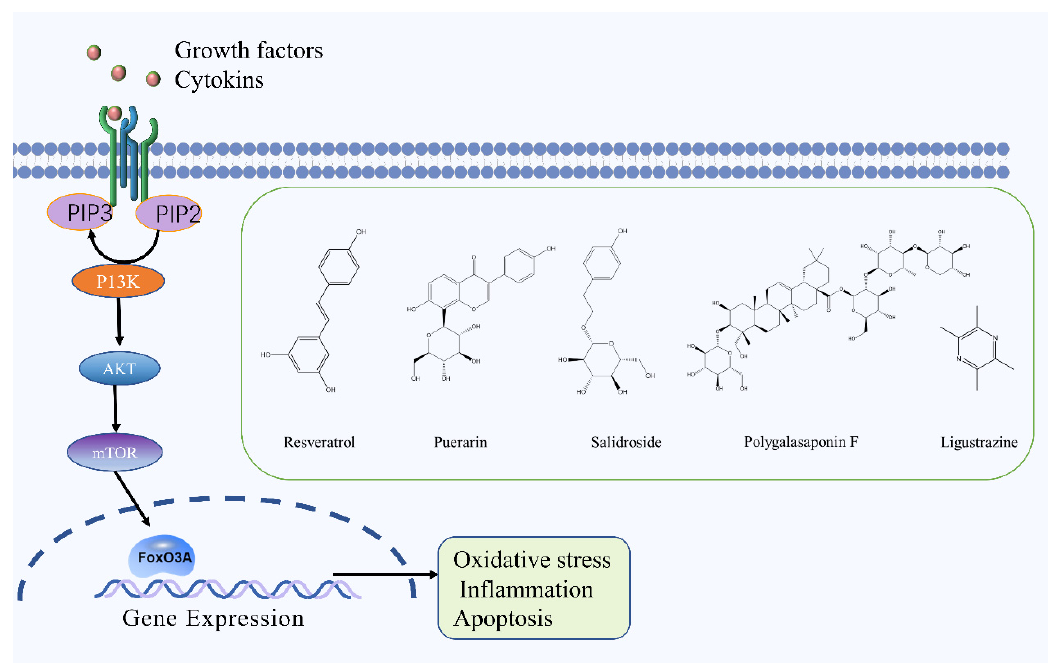
Figure 6. PI3K/Akt signaling pathway and the chemical structure of natural compounds.